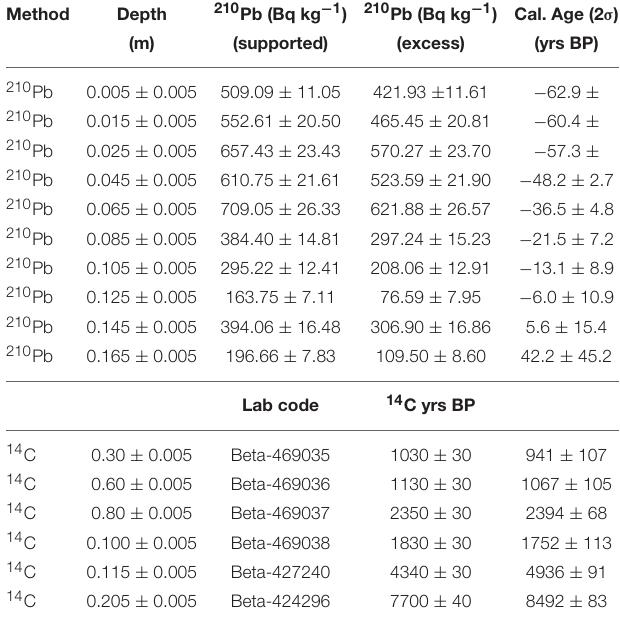
TABLE 1 | Lago Caranã 210 Pb and AMS radiocarbon